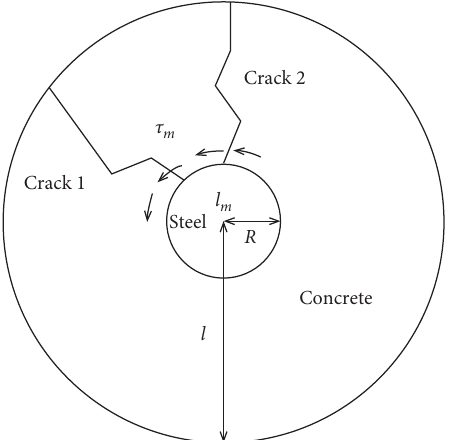
Figure 1: Schematic diagram of concrete crack development. τ m —the bond force of RC, N; R —radius of reinforcing bar, mm; l —radius of RC cylinder, mm.